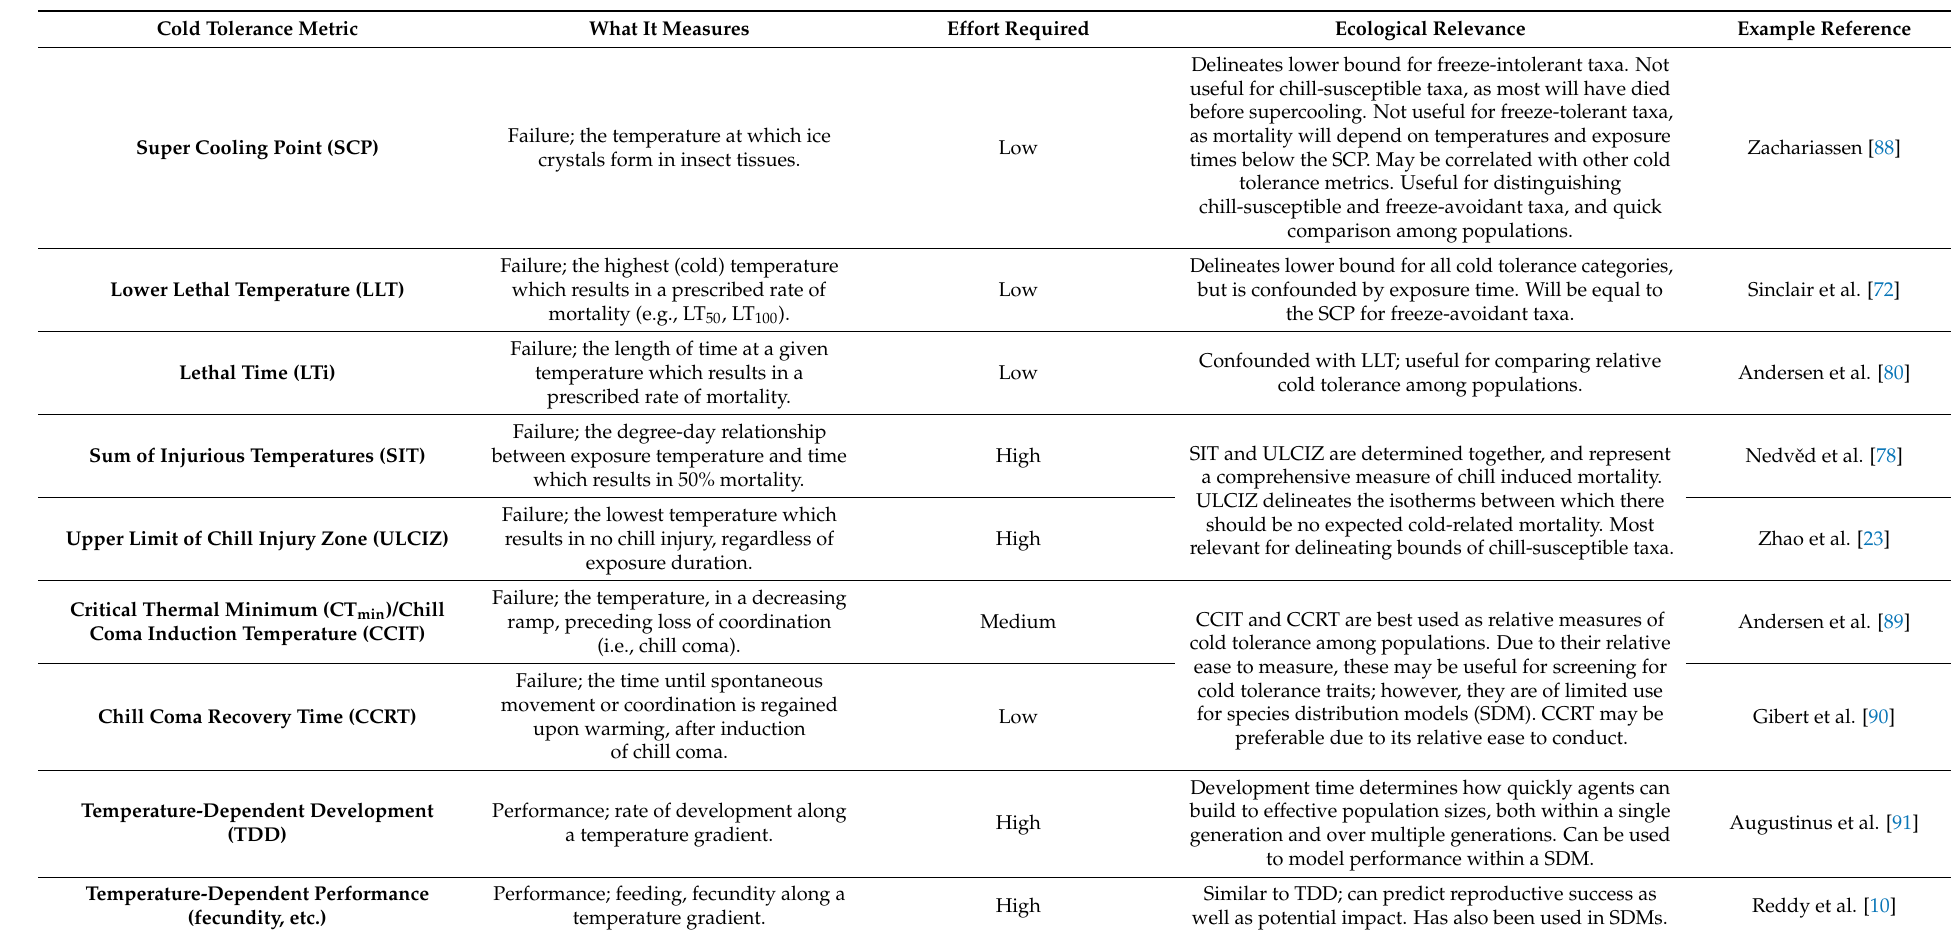
Table 1. Metrics used to describe cold tolerance of